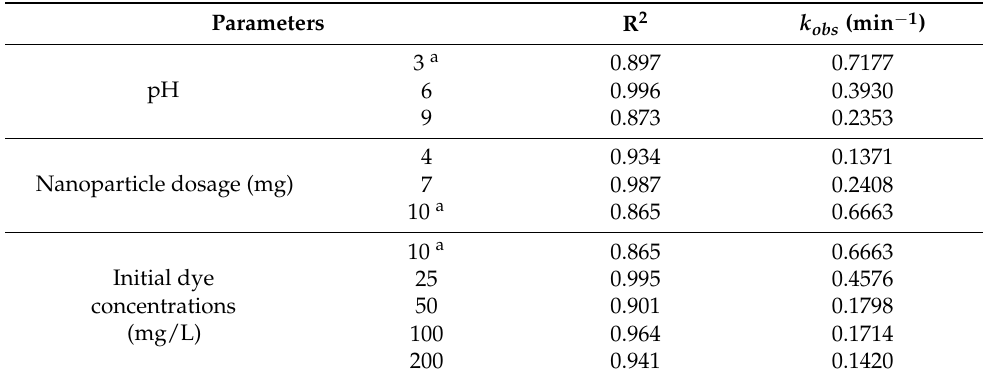
Table 3. Summary of R 2 and pseudo first-order rate constant of the studied parameters in MO degradation using Fe/Cu/Ag 5:1:0.2.